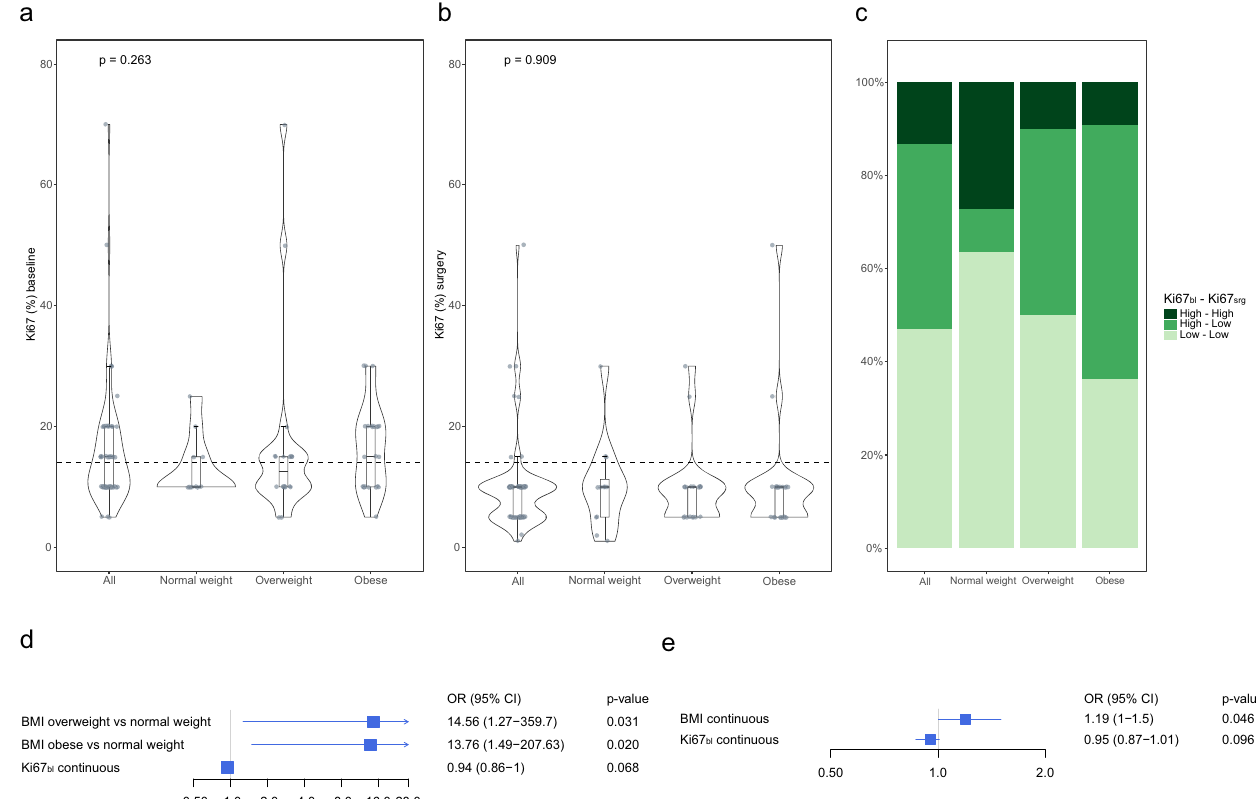
Fig. 2 Association between Ki67 index and BMI. a Distribution of Ki67 bl according to BMI. Violin plots indicate the probability density of the data, and box plots represent the median (bold line) and interquartile range (rectangle). Dots report the distribution of the observed values. The dashed line represents the 14% Ki67 cut-off. b Distribution of Ki67 srg according to BMI. Violin plots indicate the probability density of the data, and box plots represent the median (bold line), interquartile range (rectangle) and the lower and upper whiskers (the two lines outside the box). Dots report the distribution of the observed values. c Stacked bar plot of percentage of Ki67 bl – Ki67 srg groups according to BMI category. The Ki67 bl – Ki67 srg groups are displayed on top of each other and are indicated by different colors. Low – low = Ki67 bl and Ki67 srg < 14%. High – low = Ki67 bl ≥ 14% and Ki67 srg < 14%. High – high = Ki67 bl and Ki67 srg ≥ 14%. Multivariable logistic models adjusted for continuous